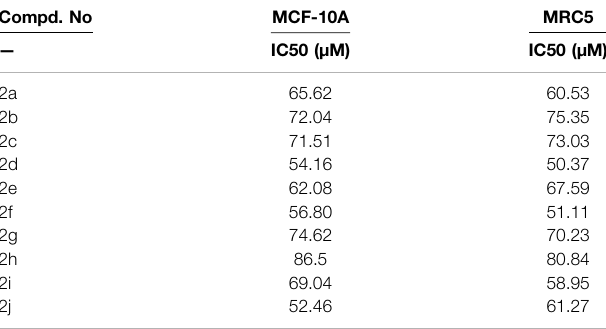
TABLE 2 | In vitro cytotoxicity of chitosan derivatives (2a-2j) on normal cells. Compd. No MCF-10A